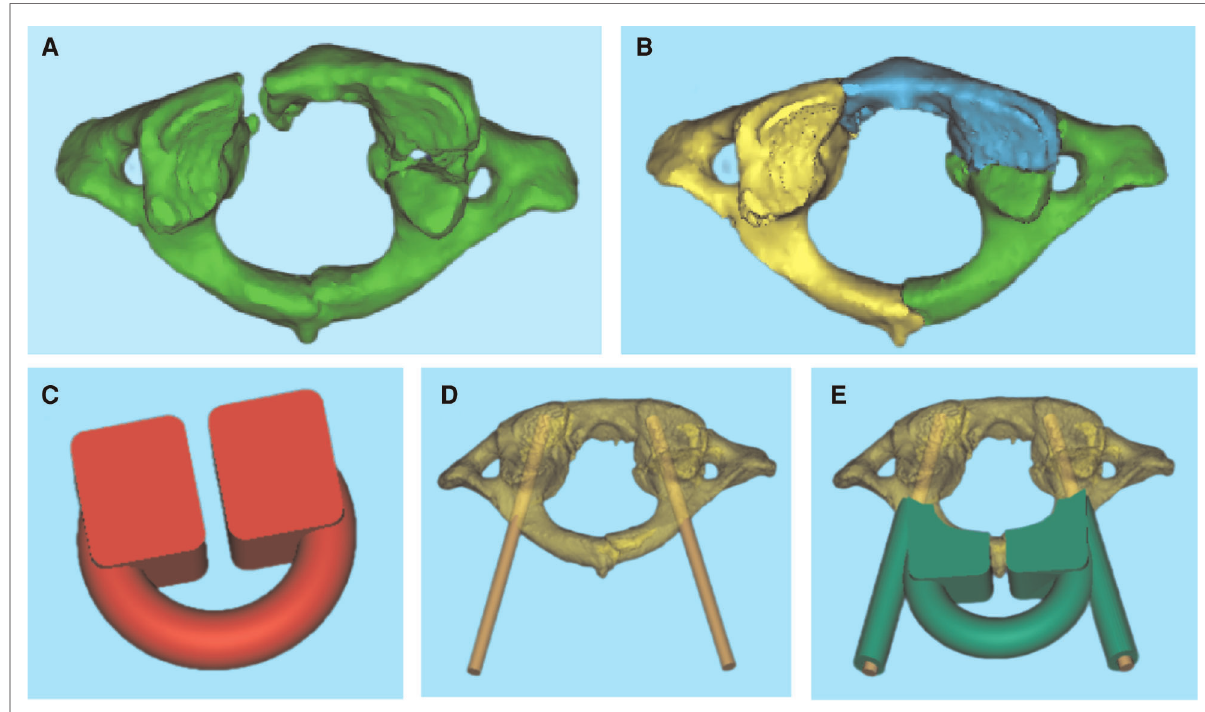
FIGURE 1 ( A – E ) Virtual reduction of the fracture fragments and individualized 3D printed navigation template were prepared according to the angle of screw